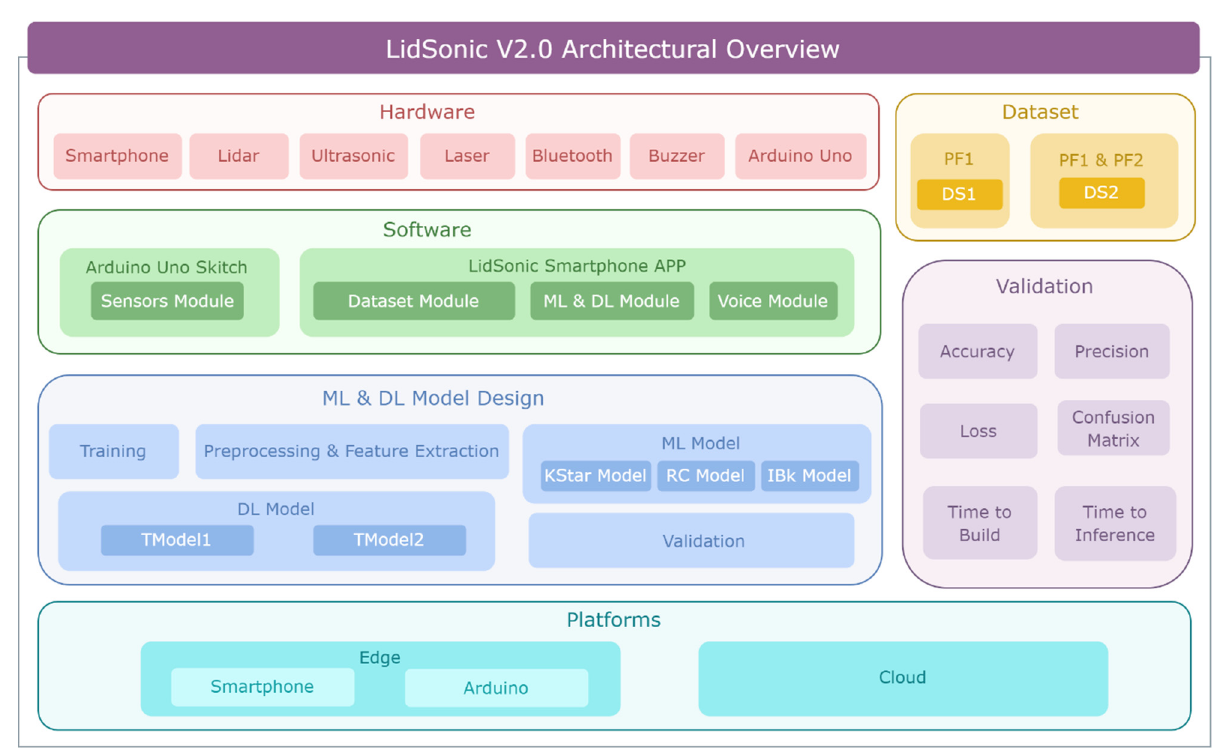
Figure 5. LidSonic V2.0 Overview (Architectural).